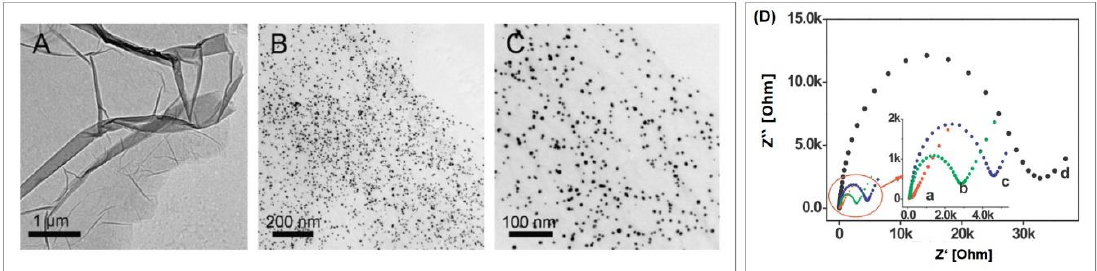
Figure 17. ( A ) High-resolution transmission electron microscopy (HRTEM) image of graphene oxide